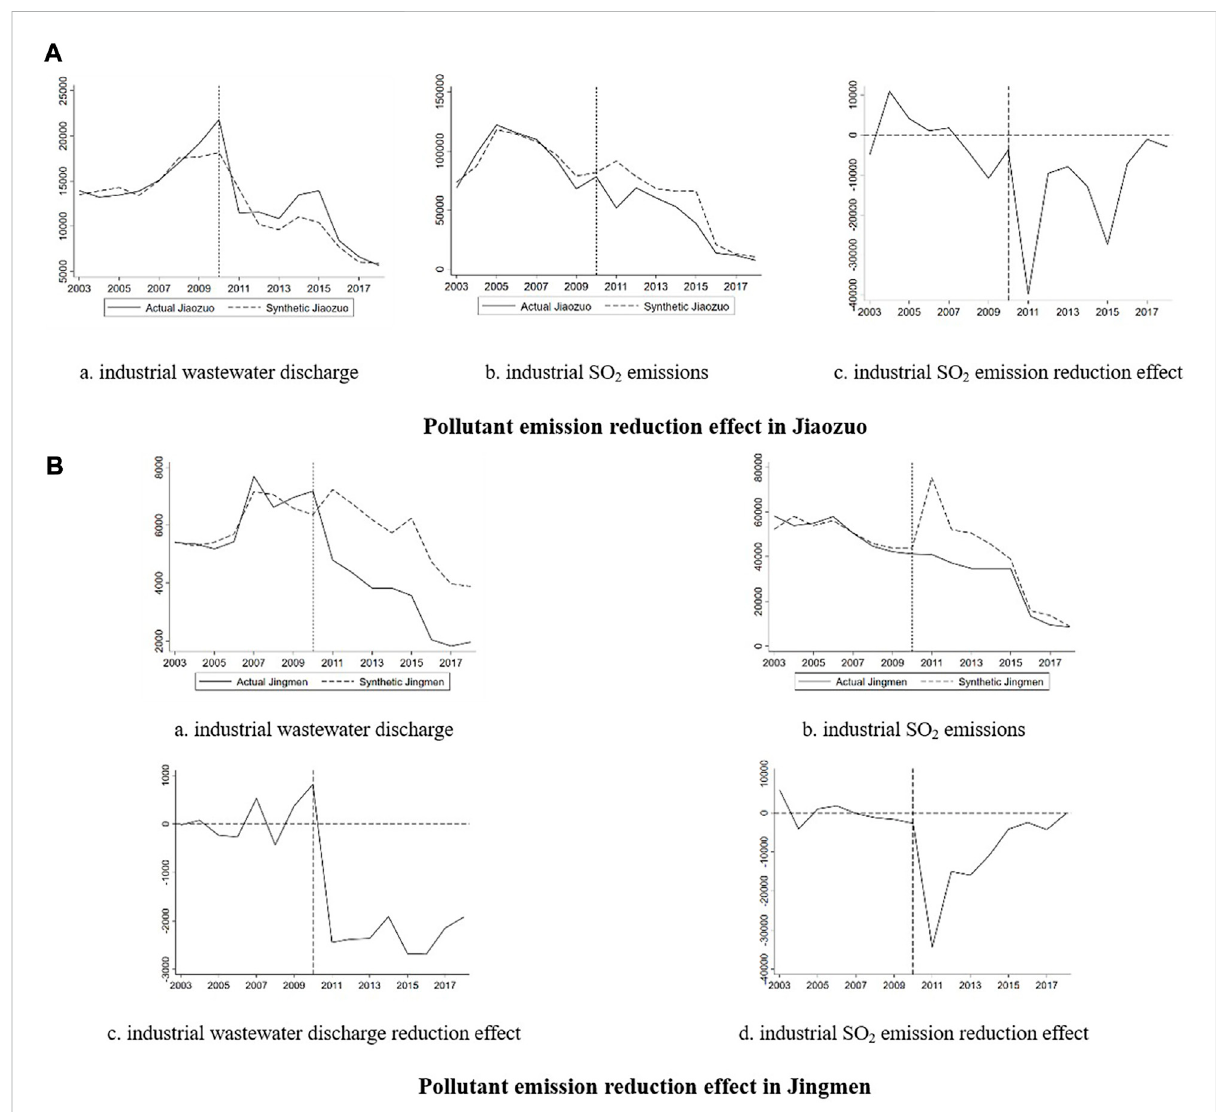
FIGURE 3 Pollutant emission reduction effect in Jiaozuo and